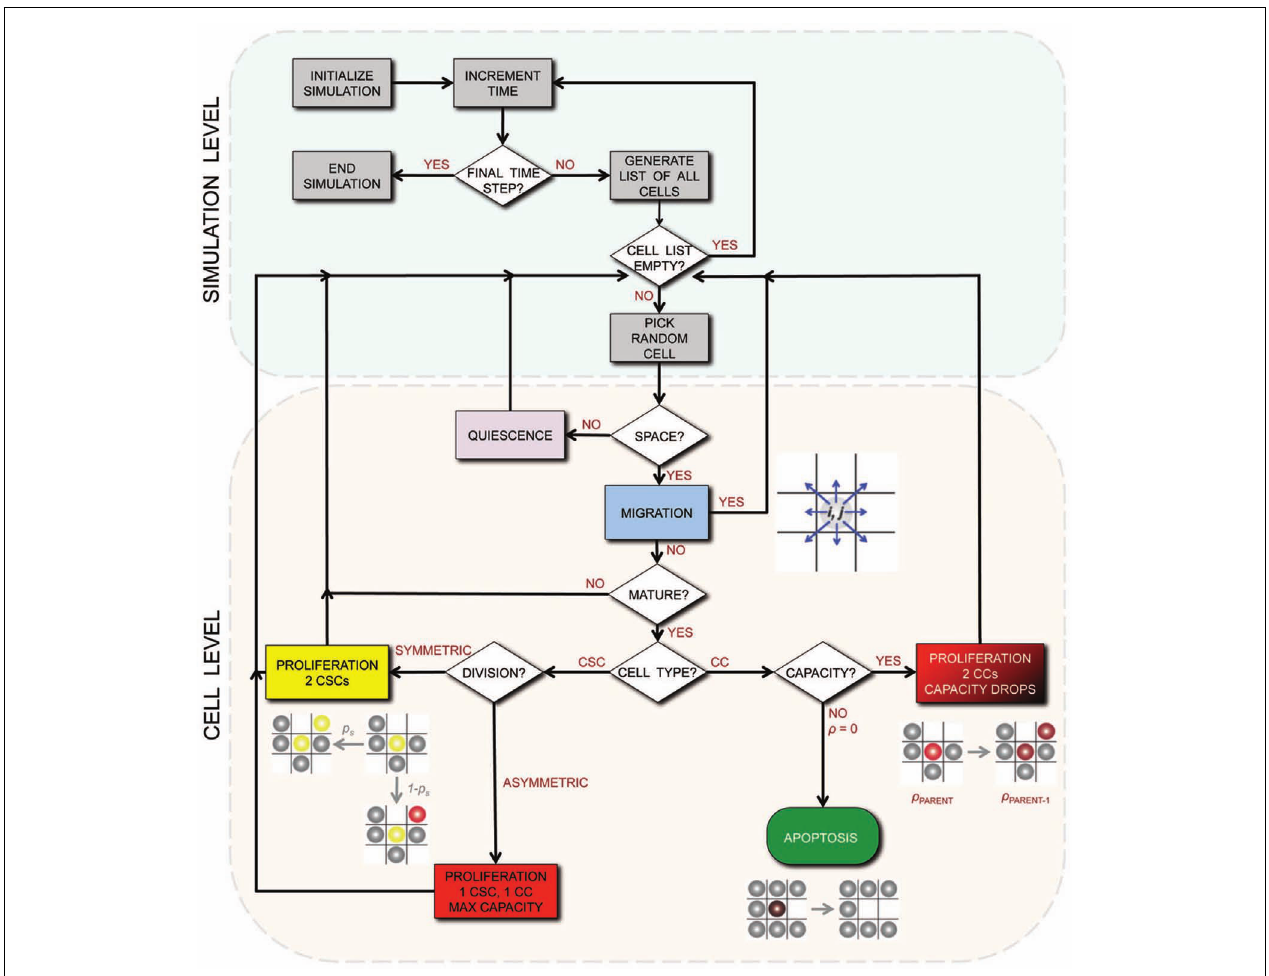
FIGURE 1 | Flowchart of the simulation process and decisions on the cell level. CSC, Cancer stem cell; CC, non-stem cancer cell; ρ , proliferation capacity.